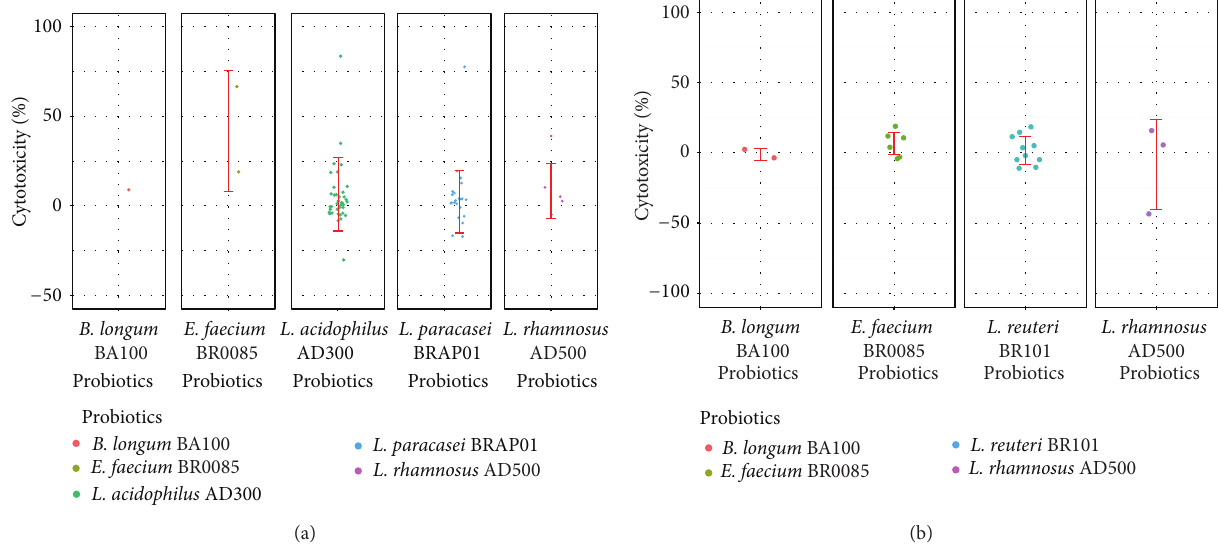
Figure 2: Distribution of the probiotic effects on the NK cytotoxicity variations. (a) IFN- 𝛾 group. (b) IL-10 group. Some probiotics exhibited good potential to enhance the NK activity, such as E. faecium BR0085 in both groups. The probiotics in IFN- 𝛾 group possessed a significant capability to increase the NK cytotoxicity compared to the IL-10